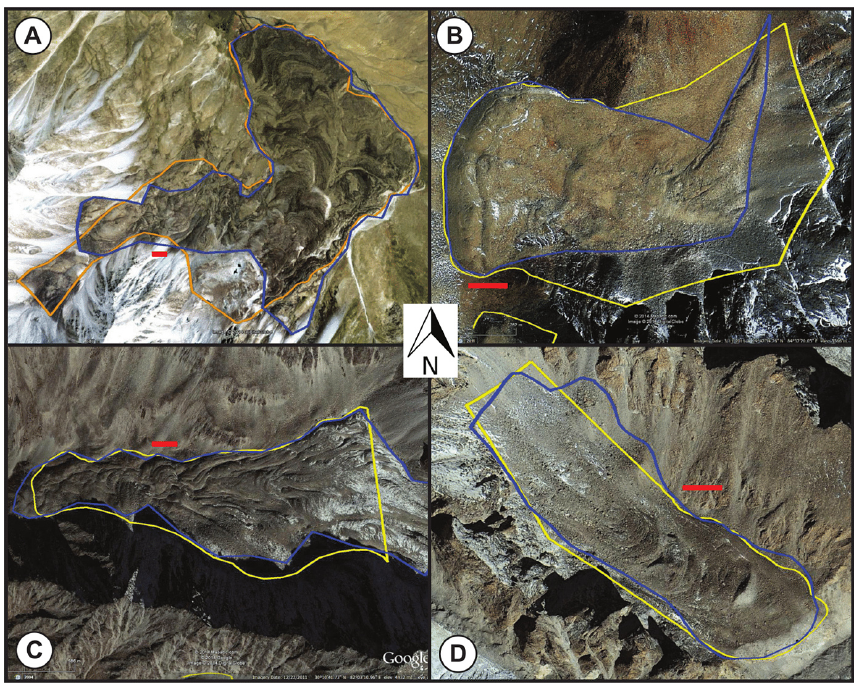
Figure 2. Examples of rock glaciers mapped by two different persons (red line = 100m). Coordinates (lat/long) are for (a) 37.07/72.92; (b) 29.71/84.54; (c) 30.18/82.05; (d) 30.18/82.22. All copyrights Image © 2014